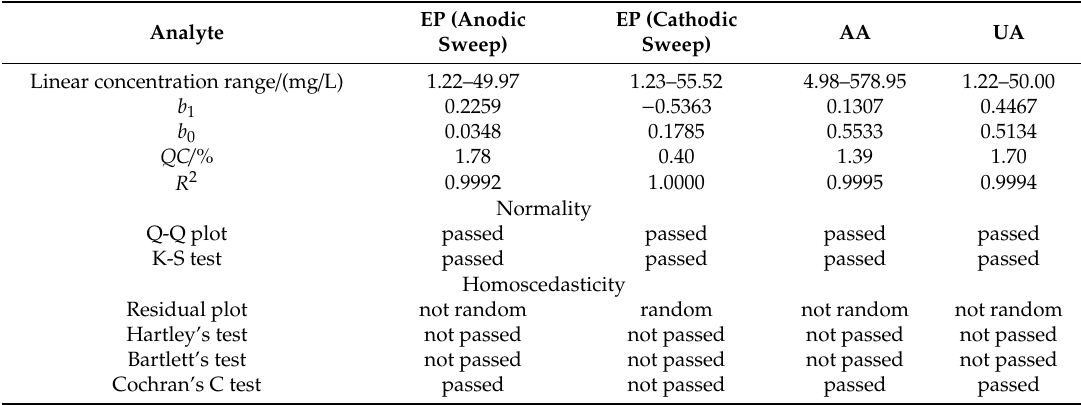
Table 2. A summary of the linear concentration range parameters using the unweighted linear regression model, normality test results, and homoscedasticity test